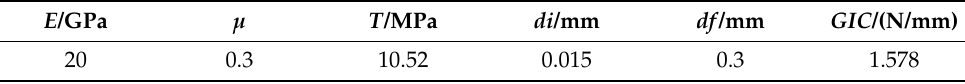
Table 3. Material properties of the numerical model.